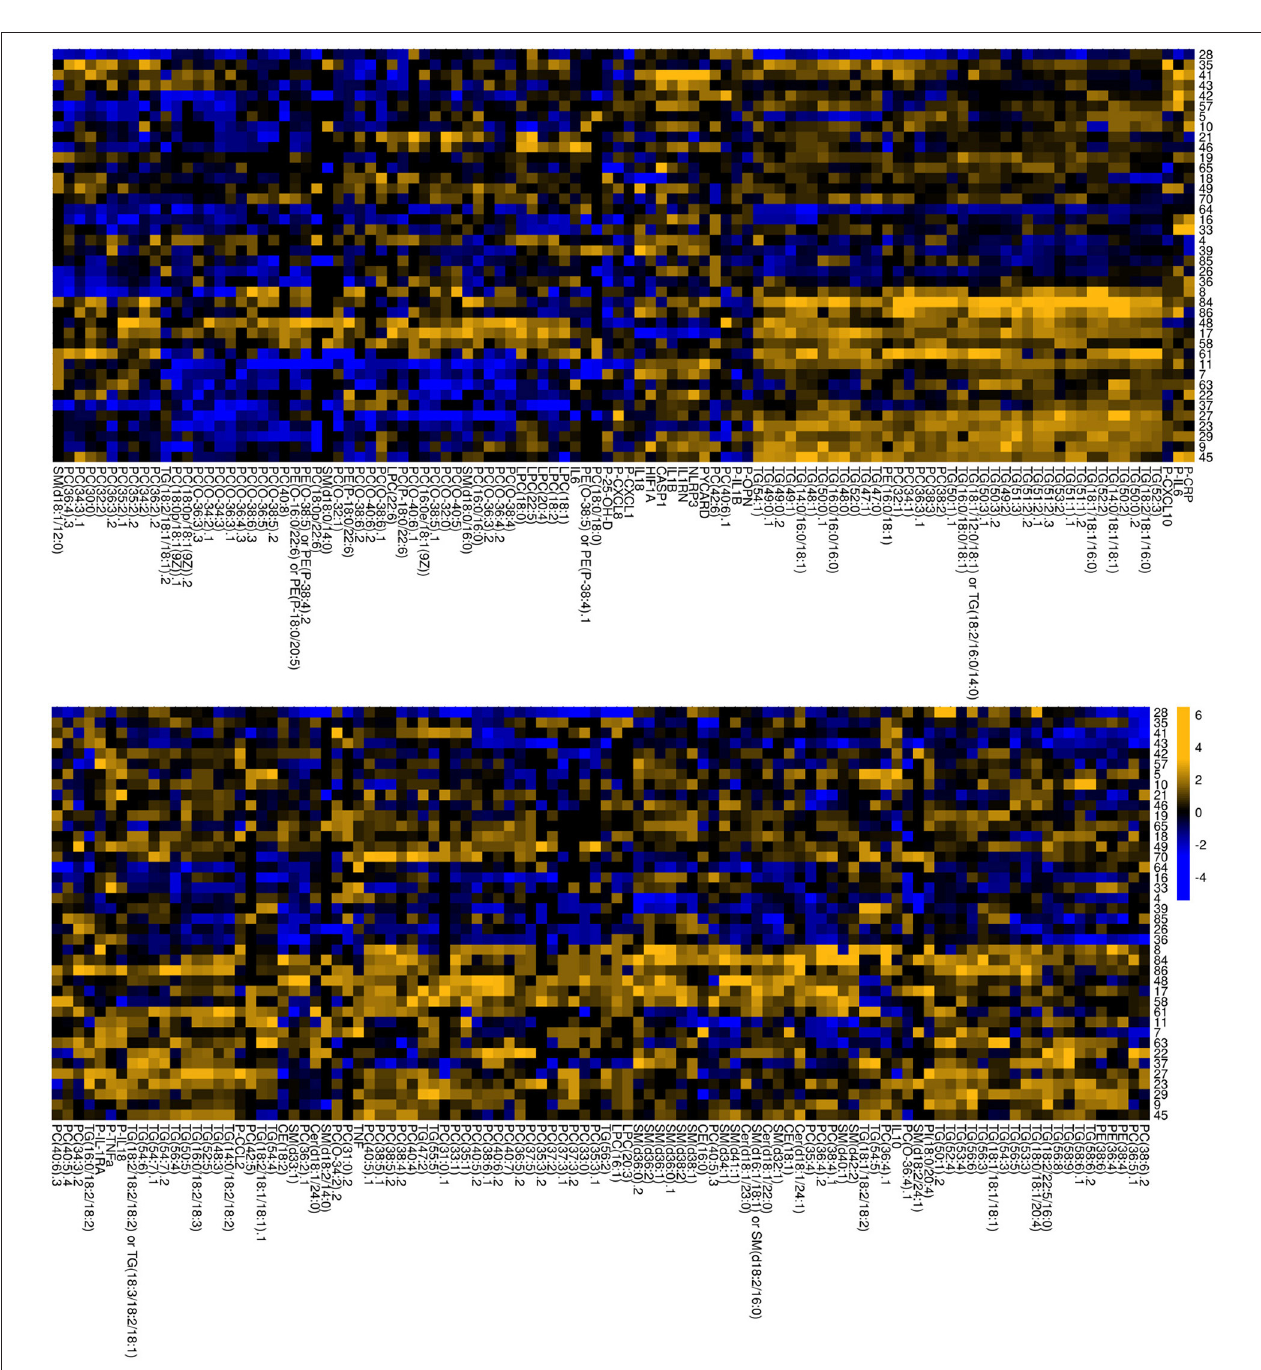
FIGURE 4 | Heatmap of fold changes in lipid and inflammatory mediator levels. The fold-change of all lipids and inflammatory factors was calculated by subtraction of the log2, autoscaled values for all participants with mental disorder minus their respective, matched controls. Column legends indicate individual lipids and immune mediators [genes, circulating cytokines (indicated with P)]. Row legends indicate individual patient-control